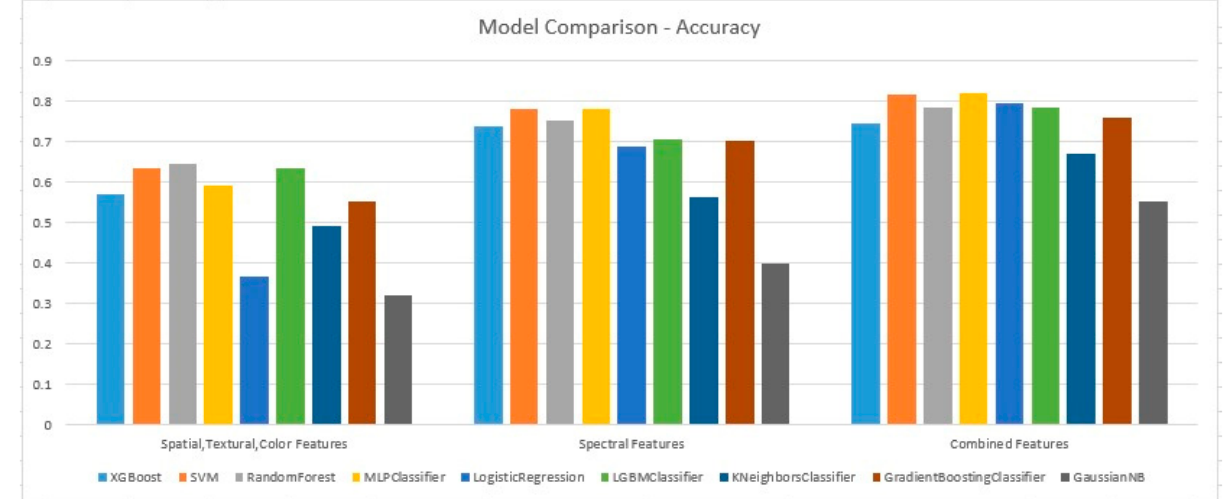
Figure 4. Comparison of the accuracy of different machine learning methods using different predic- tors. The y ‐ axis represents the kappa coefficient.